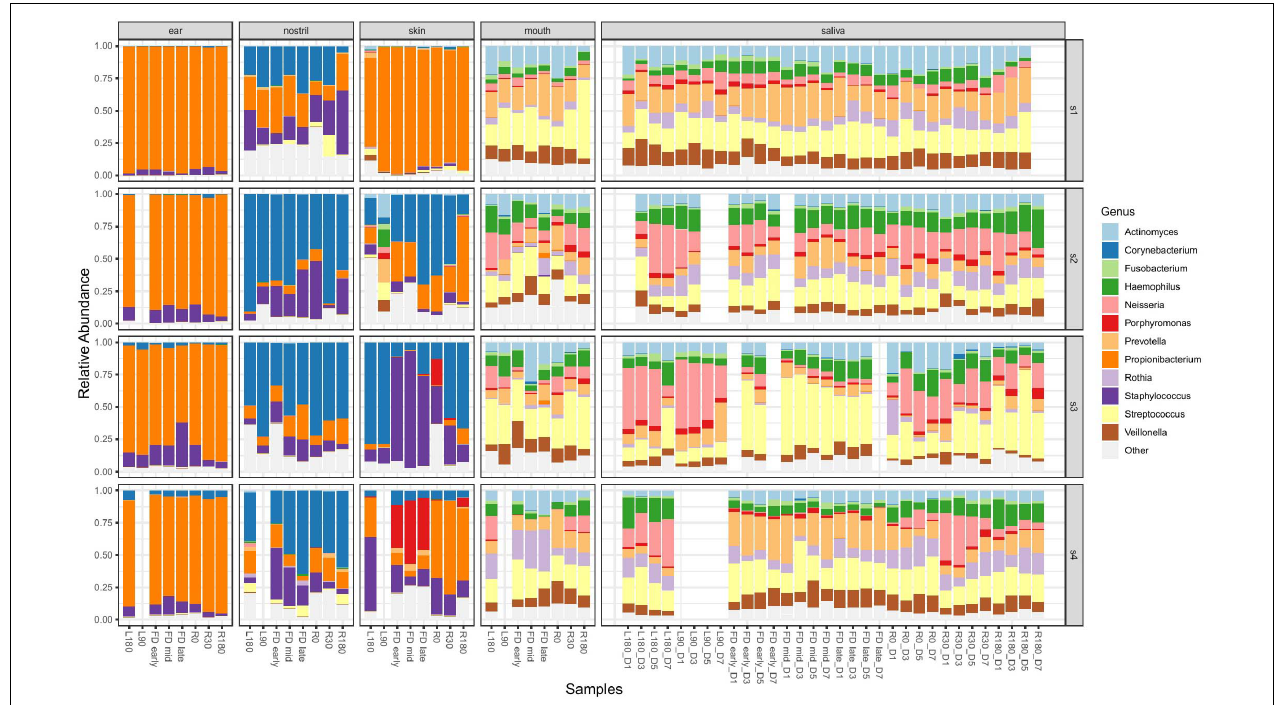
FIGURE 3 | The top 12 genera with the highest relative abundance across all astronaut samples pre-, during and post-flight. The body locations are separated into individual columns and each astronaut is represented as a row. The samples in each cell are arranged in chronological order to display the change in the microbiomes over